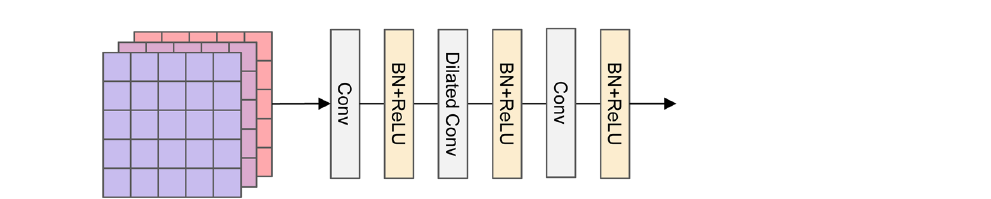
Figure 3. Structure of dilated convolution block. The block extends the field of view through dilated convolutions, providing the ability to perceive global information.